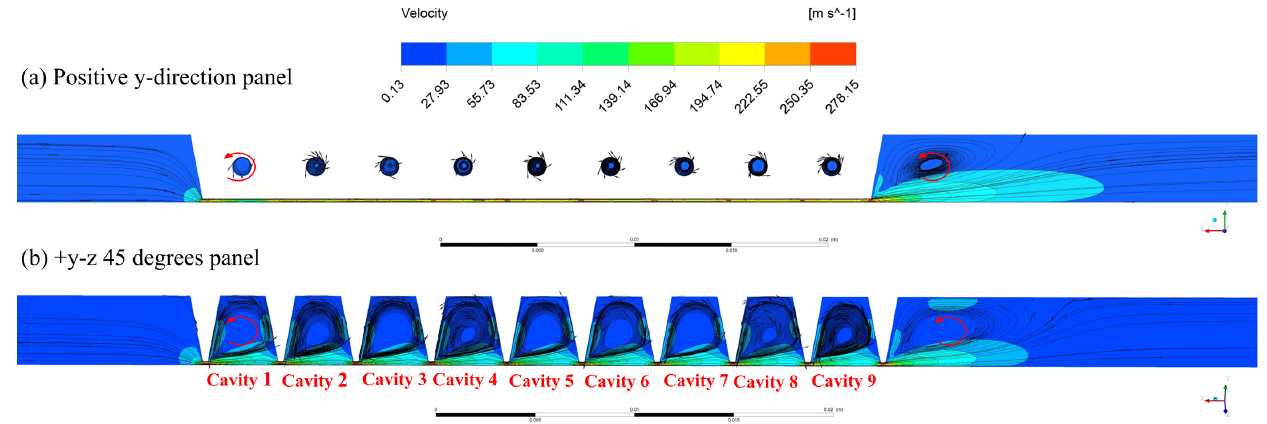
ω Ω ω Figure 15. Surface streamline and velocity contour of HDLS ( = 5000 rpm, = 50 Hz). Ω Figure 15. Surface streamline and velocity contour of HDLS ( ω = 5000 rpm, Ω = 50 Hz). Figure 15. Surface streamline and velocity contour of HDLS ( = 5000 rpm, = 50 Hz). Furthermore, the turbulence kinetic energy contours of the HDLS on both the +y+z Furthermore, the turbulence kinetic energy contours of the HDLS on both the +y+z Furthermore, the turbulence kinetic energy contours of the HDLS on both the +y+z 45 degree and -y-z 45 degree panels are drawn in Figure 16. The clearance on the +y+z 45 45 degree and -y-z 45 degree panels are drawn in Figure 16. The clearance on the +y+z 45 degree and -y-z 45 degree panels are drawn in Figure 16. The clearance on the +y+z 45 degrees panel shown in Figure 16a is slightly larger than 0.19 mm, which is slightly lower 45 degrees panel shown in Figure 16a is slightly larger than 0.19 mm, which is slightly degrees panel shown in Figure 16a is slightly larger than 0.19 mm, which is slightly lower than 0.21 mm on the -y-z 45 degrees panel. The different velocity gradients in the center lower than 0.21 mm on the -y-z 45 degrees panel. The different velocity gradients in the than 0.21 mm on the -y-z 45 degrees panel. The different velocity gradients in the center of the cavity can be found as the red sections show in Figure 16. Meanwhile, the last jet center of the cavity can be found as the red sections show in Figure 16. Meanwhile, the last of the cavity can be found as the red sections show in Figure 16. Meanwhile, the last jet flow behind the tenth blade on the +y+z 45 degree panel is slightly shorter than that on jet flow behind the tenth blade on the +y+z 45 degree panel is slightly shorter than that on flow behind the tenth blade on the +y+z 45 degree panel is slightly shorter than that on the -y-z 45 degree panel. the -y-z 45 degree panel. the -y-z 45 degree panel.